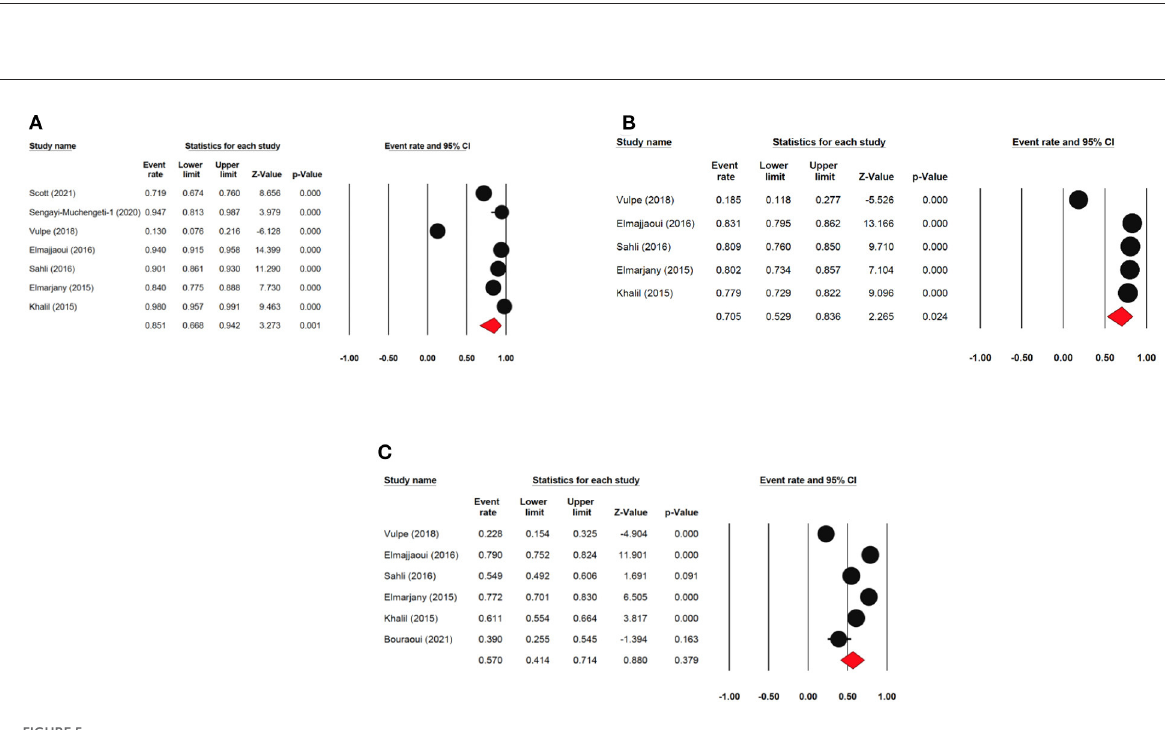
FIGURE5 Forest plot showing the LRR. (A) pooled 1-year DFS; (B) pooled 3-year DFS; (C) pooled 5-year